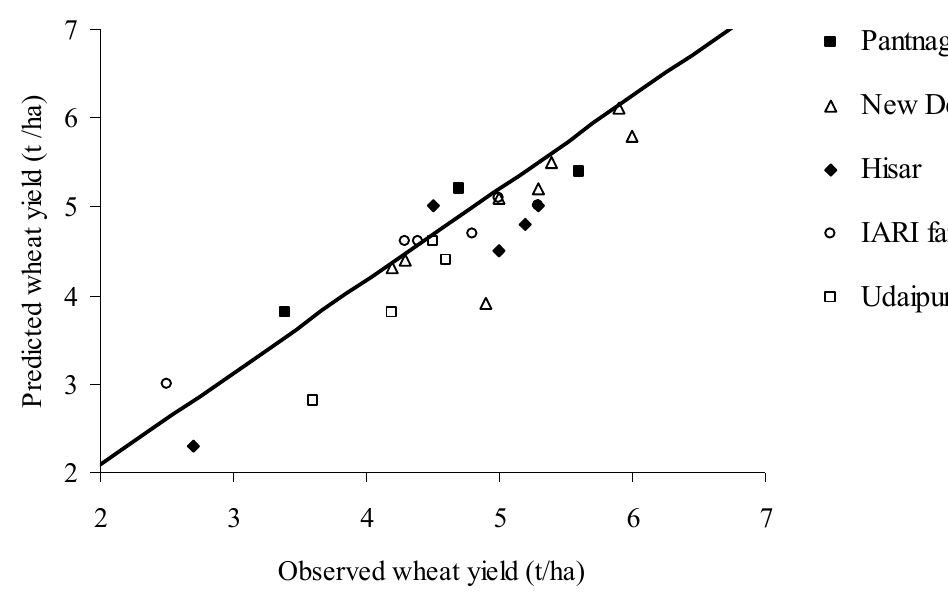
FIGURE 5. Yields of wheat predicted by the model QUEFTS and observed in different locations in India.